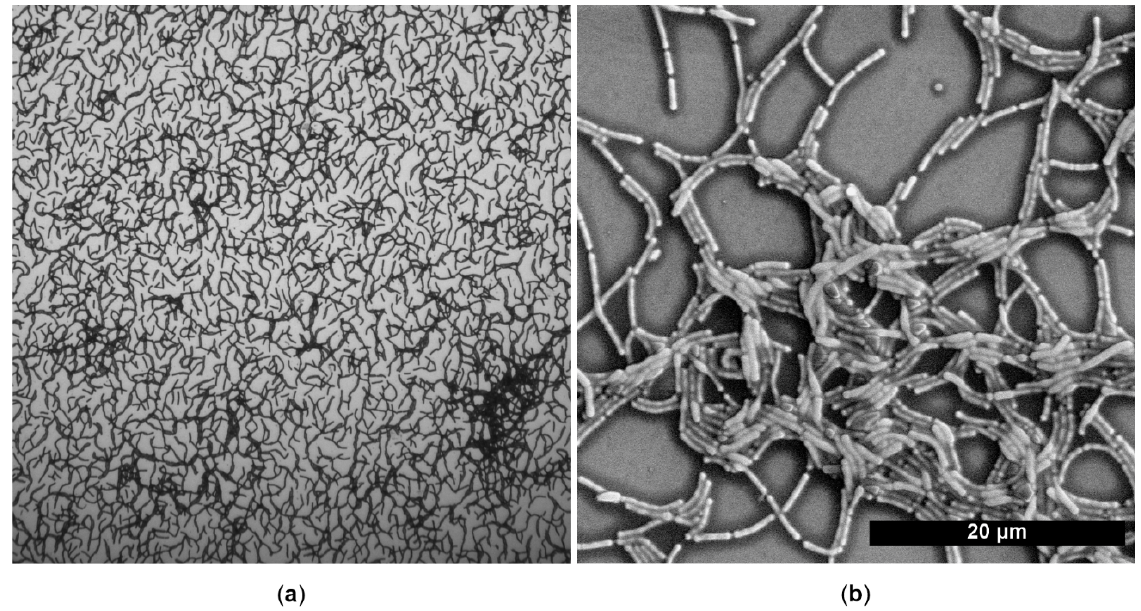
Figure 3. Final coating (GSHAuGG) visualized with ( a ) optical microscope (objective magnification 100×) and ( b ) scanning electron microscope. In the latter case, the surfaces were sputter deposited with a thin gold layer before imaging.